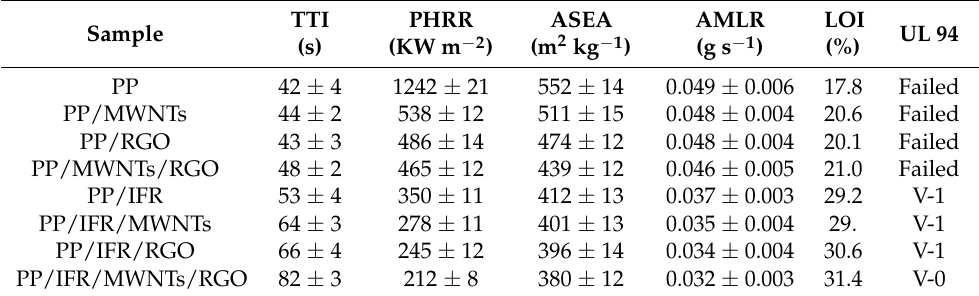
Table 7. Cone calorimetry, LOI, and UL 94 analysis results for various samples. Reprinted with permission from Ref. [189]. Copyright 2014,